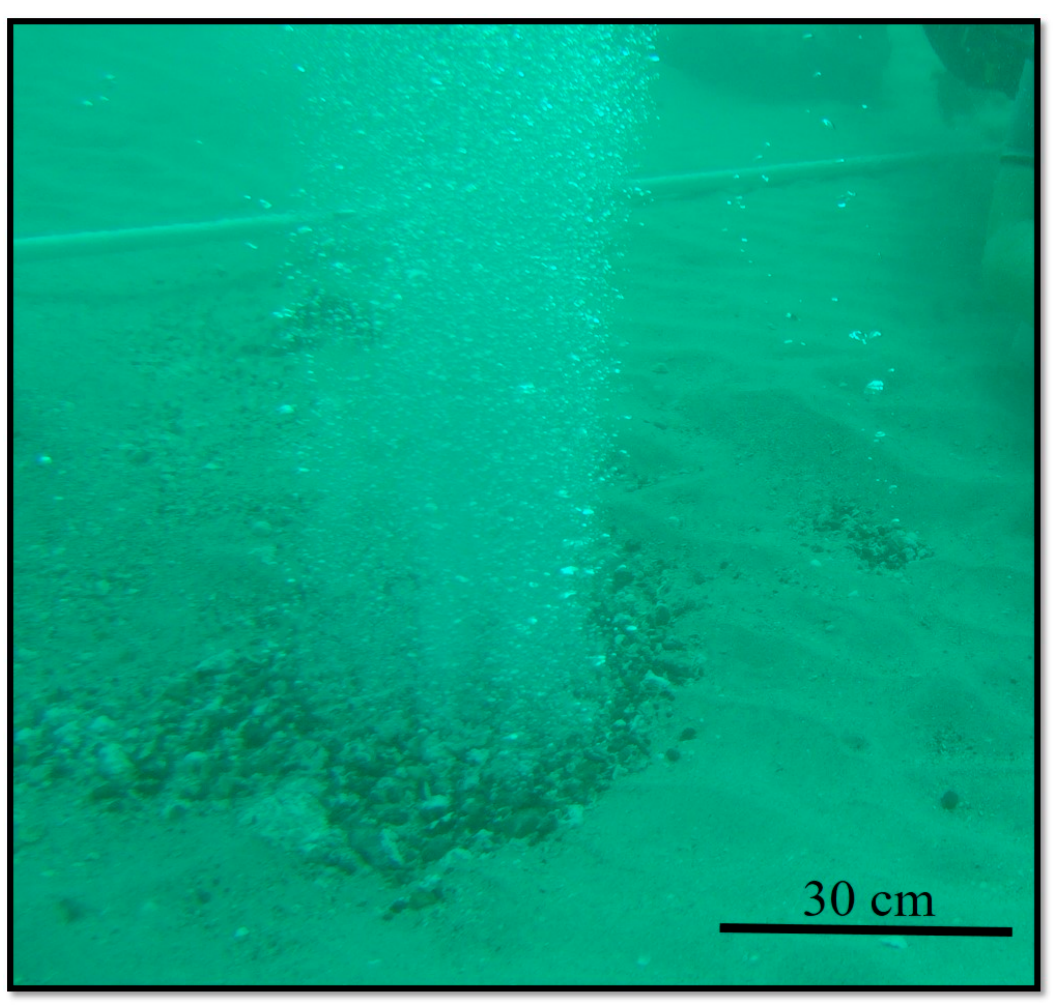
Figure 7. Photograph of the active hydrothermal vent of the area with hydrothermal activity (WHA) at Site 2 (S2).